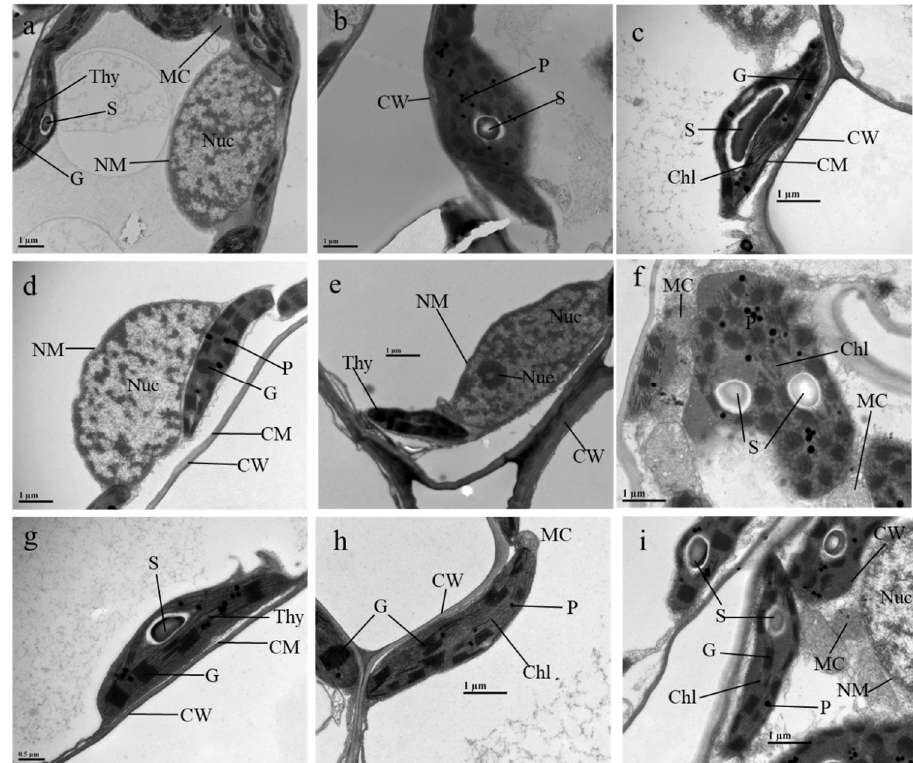
Figure 4. Effects of 5-aminolevulinic acid or salicylic acid (ALA/SA) combined with citric acid (CA) on electron micrographs of leaf mesophyll cells of manganese (Mn)-treated sunflower plants. ( a – c ) represent electron micrographs of mesophyll cells of sunflowers under CK, Mn and Mn + CA treatment, respectively; ( d – f ) represent electron micrographs of mesophyll cells of sunflowers under ALA, Mn + ALA and Mn + CA + ALA treatment, respectively; ( g – i ) represent electron micrographs of mesophyll cells of sunflowers under SA, Mn + SA and Mn + CA + SA treatment, respectively. CK, control plants without any treatment; Mn, plants exposed to 0.8 g kg − 1 of manganese for 7 days; CA means 20 mmol kg − 1 citric acid treatment. ALA/SA indicates spraying with 20/100 mg L − 1 ALA/SA. Mn + CA, plants treated with CA for 7 days after Mn treatment. Mn + CA + ALA/SA treatment indicates plants treated with ALA/SA for one week after CA treatment. Plates explanation: MC, mitochondria; Chl, chloroplasts; NM, nuclear membrane; Thy, thylakoid; Nuc, nucleus; Nue, nucleolus; CW, cell wall; CM, cell membrane; P, plastoglobuli; S, starch; G, grana; Vac, vacuole. ( a , b , d , e )—×20,000, ( c , f , h , i )—×25,000, ( g )—×30,000.